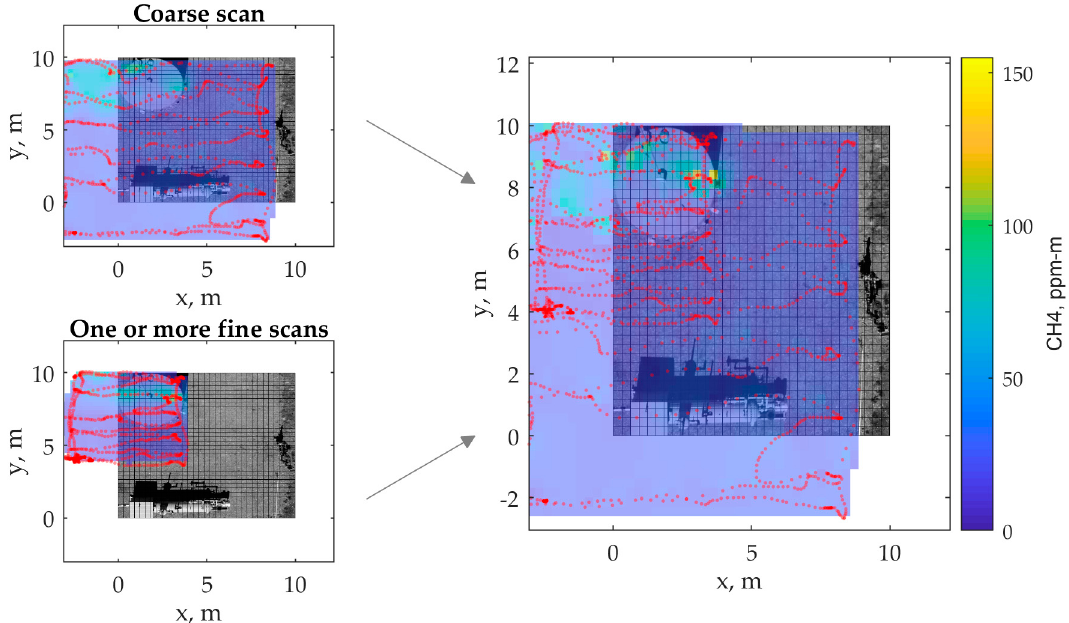
Figure 2. Case study at Methane Emissions Technology Evaluation Center (METEC) showing the flight procedure and two flights superimposed on one another. The initial flight detected a leak over the tank, which was followed by a second, more focused flight. Red lines indicate the RMLD-UAV flight tracks.